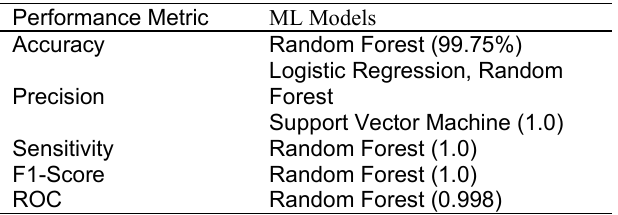
Table 12. Best Performing ML Models